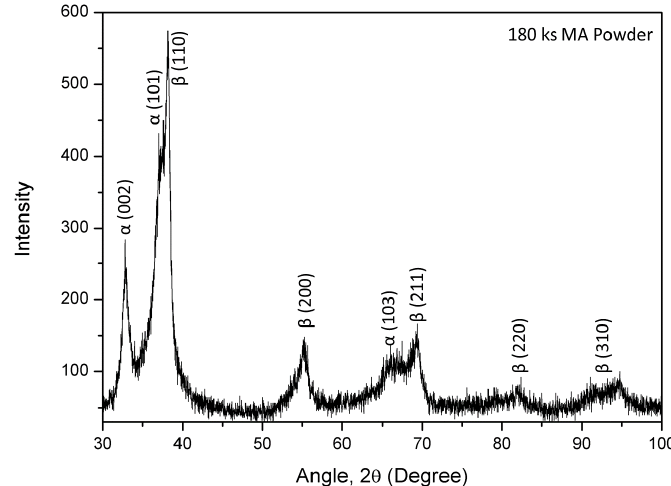
Figure 2. XRD patterns of the mechanically alloyed powder.